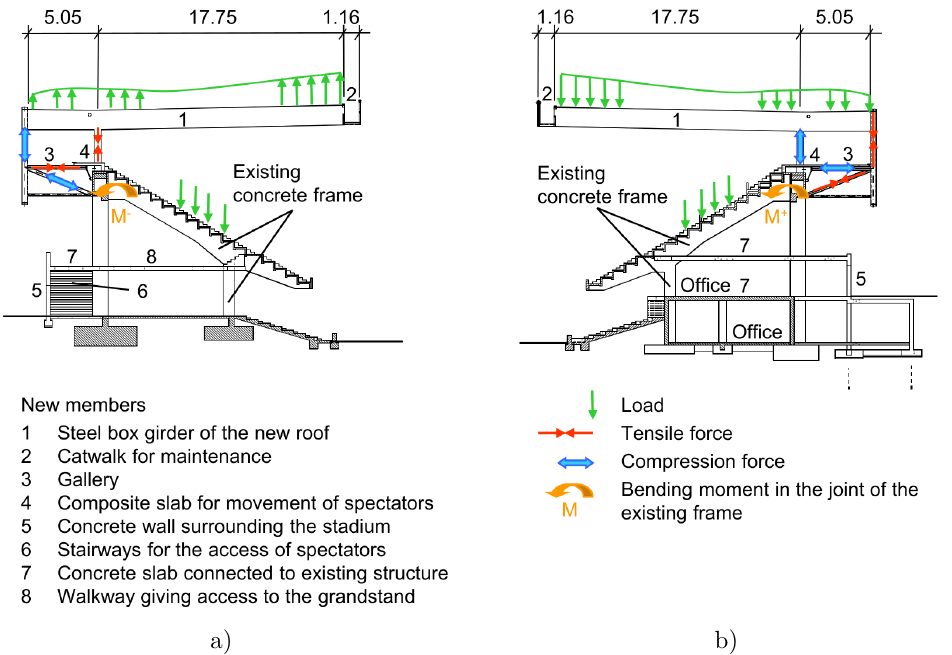
Figure 3. Cross-sections after refurbishment and expansion (courtesy of Cesma Ingenieros): a) standard frame; b) frame of main